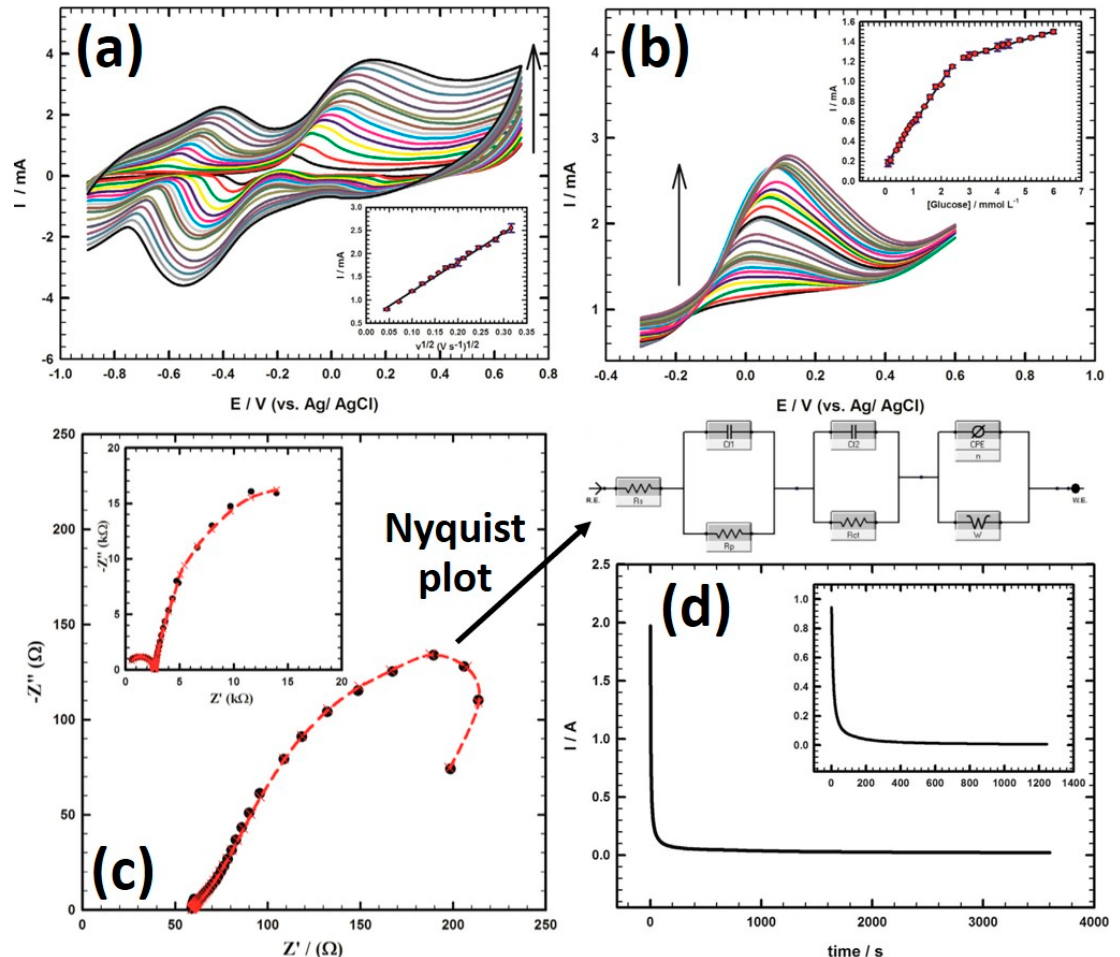
Figure 3. ( a ) CVs of 5 mM glucose/0.1 M NaOH at graphite/SrPdO 3 /Au nano electrode at different scan rates (0.002–0.100 V s − 1 ) (Inset figure: the plot of the anodic peak current values versus square root of scan rate for 5 mM glucose/0.1 M NaOH at graphite/SrPdO 3 /Au nano electrode) ( b ) LSVs of 10 mL of 0.1 M NaOH at graphite/SrPdO 3 /Au nano electrode in different concentrations of glucose (0.1–6.0 mM) (Inset figure: calibration curve for glucose for concentrations from 0.1 to 2.4 mM and from 2.8 to 6.0 mM). ( c ) Nyquist plot of graphite/SrPdO 3 /Au nano electrode and bare graphite (Inset figure: in 5 mM glucose/0.1 M NaOH at the steady-state potential (0.100 V for bare graphite and 0.400 V for the proposed sensor)). (Black circles represent the experimental measurements and dash red lines with cross symbols represent the com- puter fitting of impedance spectra). Frequency range: 0.1–100,000 Hz. ( d ) Chronoamperogram of graphite/SrPdO 3 /Au nano electrode at the steady-state potential of glucose (0.400 V) in 5 mM glucose/0.1 M NaOH (Inset figure: the same study at the oxidation potential of glucose (0.050 V)). (Reproduced with permission from [93]. Copyright Elsevier,